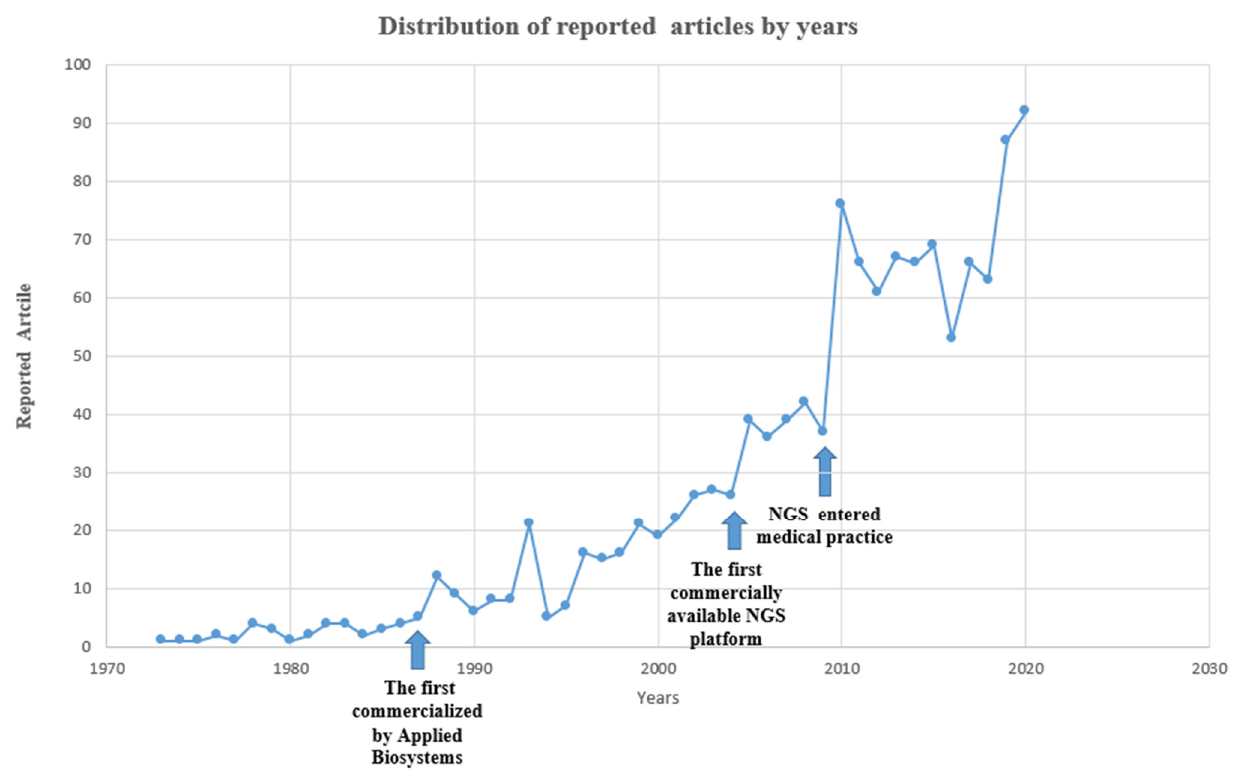
Figure 1. The exponential increase in the number of articles published in Pubmed over the past several decades regarding mutations in IHH genes. several decades regarding mutations in IHH